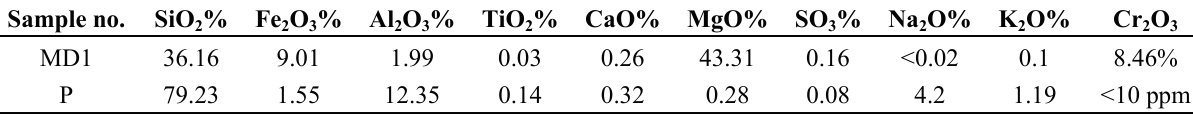
Table 4. Chemical analysis of dunite and plagiogranite